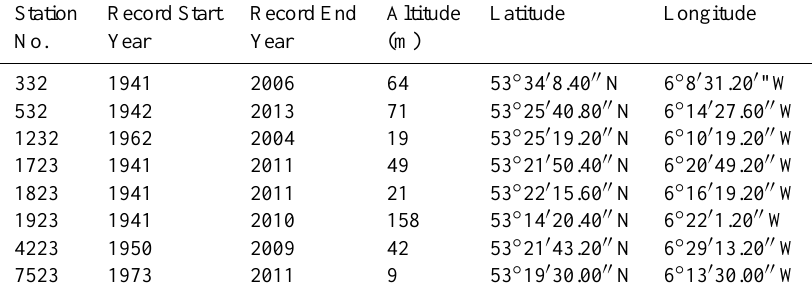
Table 1. Details of rainfall stations in study area. Station